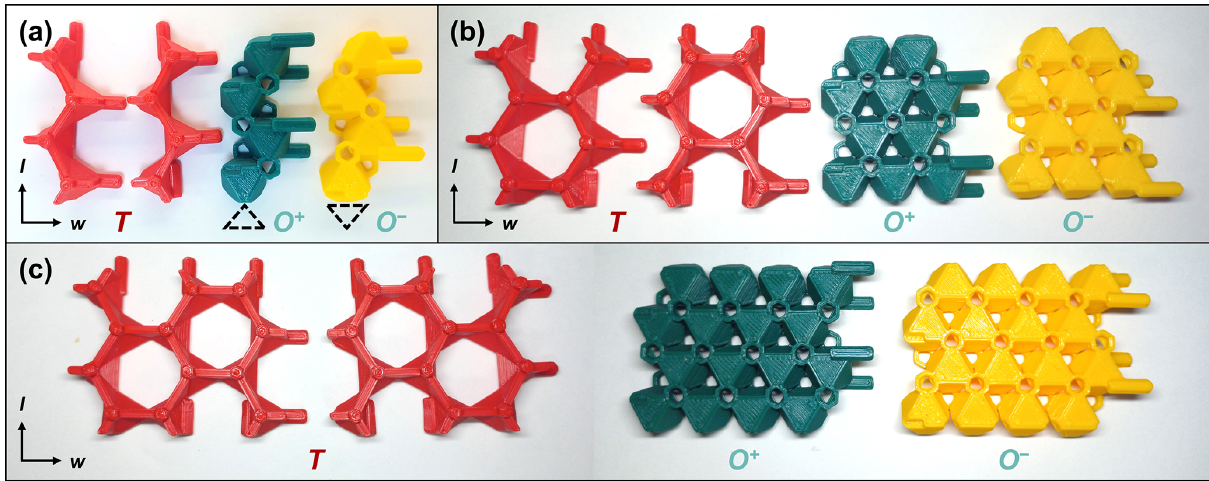
Figure 5. The four types of T and O modules for (a) single-chain ( w = 1), (b) double-chain ( w = 2), and (c) triple-chain ( w = 3) T - O - T rod modules. Note that the two variations of T modules are interchangeable, and the T + and T − designation relates only to the direction that the apices of the T modules are pointing (up and down, respectively). See Sect. S1.3 for ancillary components of TotBlocks.